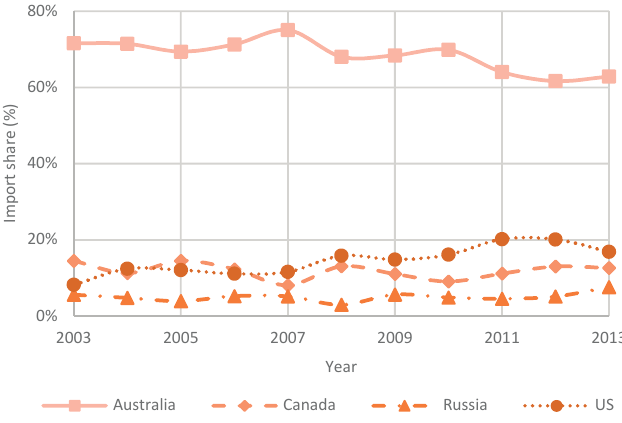
Figure 9 . Asian and European Union market import share of metallurgical coal split into major exporting regions